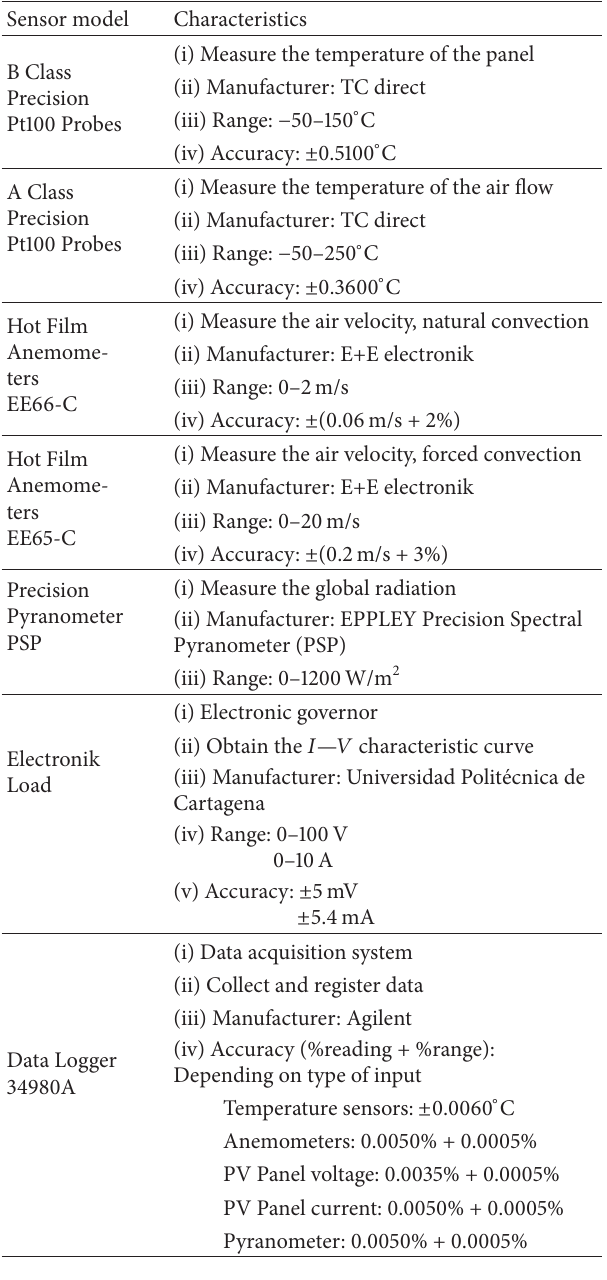
Table 1: Sensors